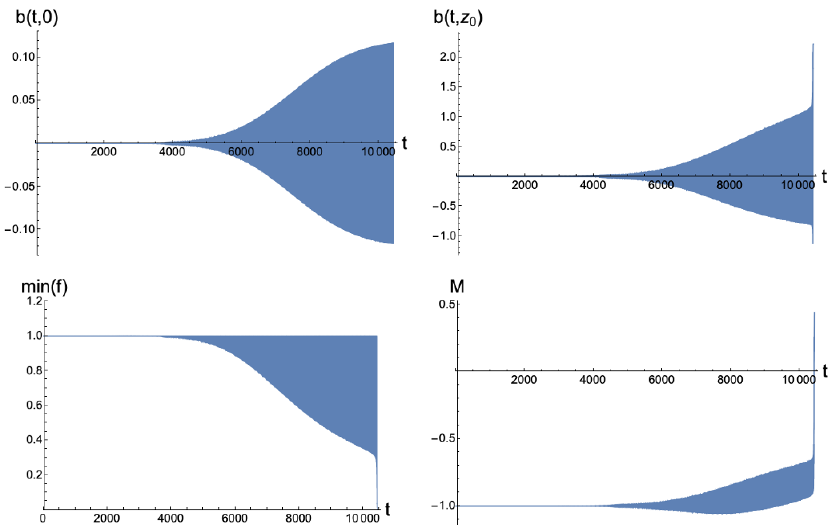
Figure 4 . Numerical simulation of a quasi-static build-up protocol with ! = 1 : 6 and time span (cid:12) = 1 : 5 (cid:2) 10 4 . In the upper two plots b ( t; 0) = b 0 ( t ) at the boundary and b ( t; z 0 ) at the tip are shown. The oscillations are so dense that they cannot be appreciated. All magnitudes evolve adiabatically following a series of TPSs until a sharp threshold at b 0 ( t col ) = 0 : 117 is reached. There the instability sets in, as re(cid:13)ected in the sharp gain of net energy density m , and the formation of an apparent horizon, signalled by the function min z f ( t; z ) approaching zero. The momentum constraint is satis(cid:12)ed to a part in 10 (cid:0) 4 throughout the whole process.